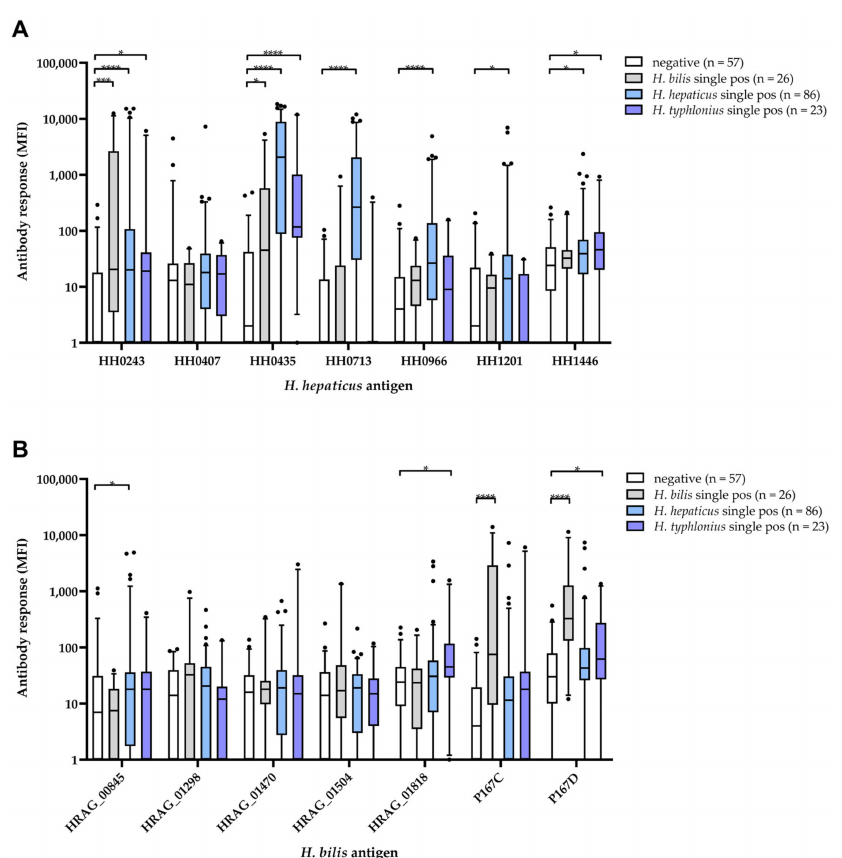
Figure 2. Antibody responses [MFI] to ( A ) H. hepaticus and ( B ) H. bilis antigens by Helicobacter multiplex DNA finder result in murine samples taken in the course of routine health monitoring. Boxes represent the 25th to 75th and whiskers the 5th to 95th percentile, solid lines show the median. Dots represent data points lying outside the 5th and 95th percentiles, respectively. Wilcoxon–Mann– Whitney test was applied to compare continuous antibody responses [MFI] in the individual DNA-